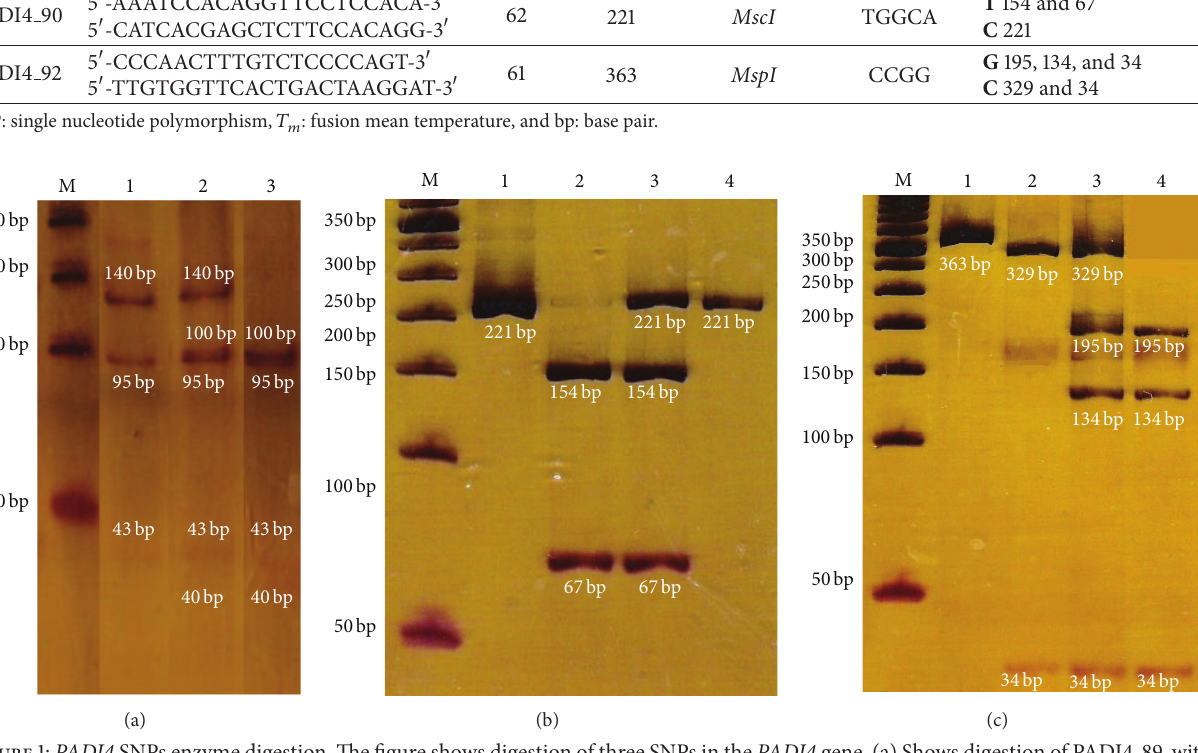
Figure 1: PADI4 SNPs enzyme digestion. The figure shows digestion of three SNPs in the PADI4 gene. (a) Shows digestion of PADI4 89, with HaeIII enzyme; lane 1 represents the A/A genotype, lane 2 A/G and 3 G/G. (b) Demonstrates PADI4 90 amplification (221bp) in lane 1 and digested products with MscI enzyme in lanes 2 (C/C genotype), 3 (C/T genotype), and 4 (T/T genotype). (c) Shows amplification product of PADI4 92 in lane 1 (363bp) and restriction products obtained with the enzyme MspI; lane 2 corresponds to the G/G genotype, lane 3 G/C, and lane 4 C/C. Visualized in 8% (29: 1) polyacrylamide gel with silver staining. M: molecular weight marker